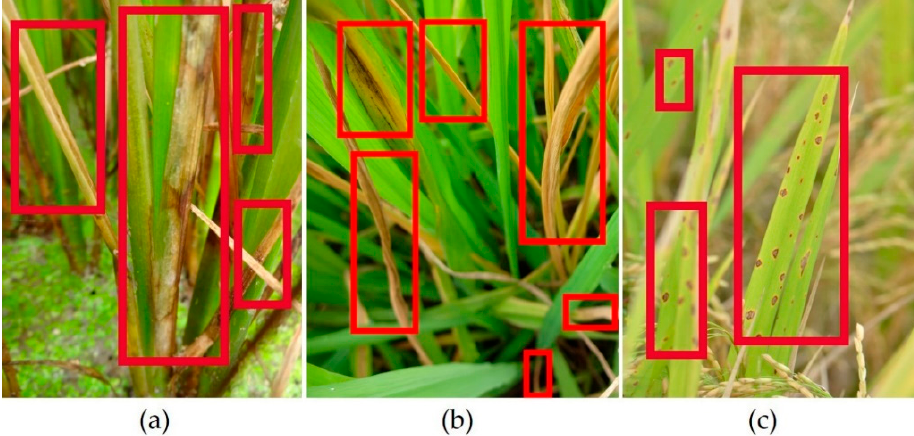
Figure 1. As shown in the red boxes, the lesion spots of rice sheath blight, rice stem borer symptoms, rice brown spot are visualized: ( a ) rice sheath blight, ( b ) rice stem borer symptoms, ( c ) rice brown spot. The images are from our image dataset, which were collected in Anhui, Jiangxi and Hunan Province, China, between June and August, 2018.